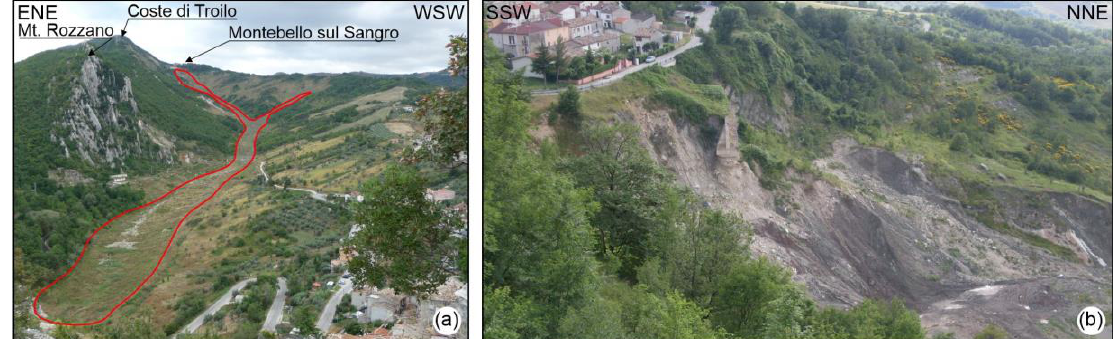
Figure 11. Photo documentation of geomorphological features of Montebello del Sangro landslide. ( a ) Panoramic view of the main earthflow; ( b ) detail of allochthonous pelagic deposits involved in the landslide phenomenon, with regressive enlargement of the landslide scarp near the Montebello sul Sangro village.